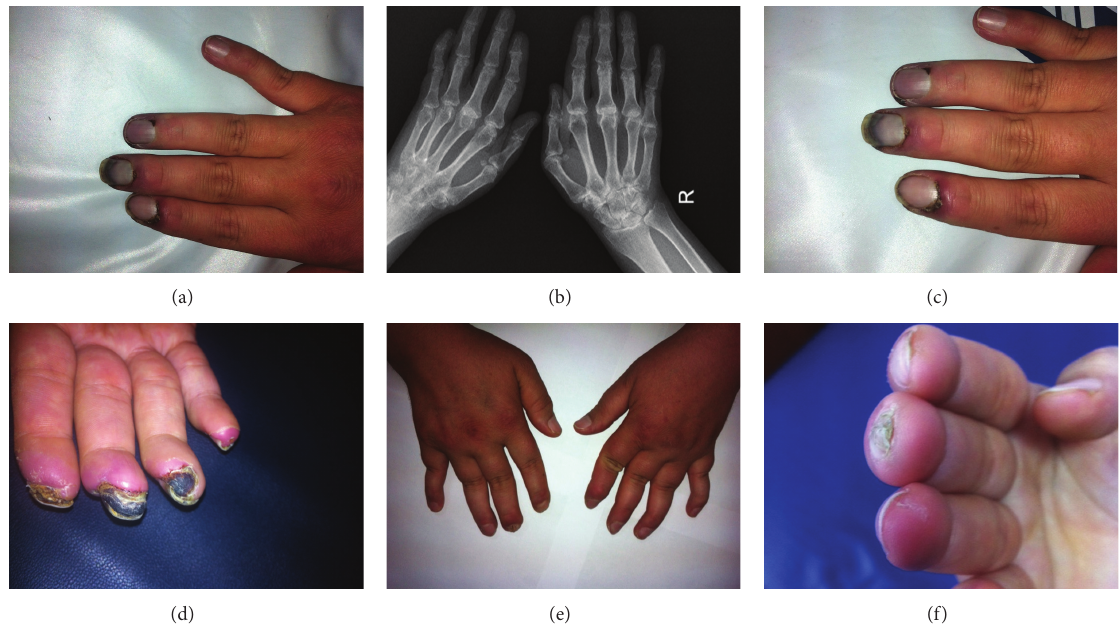
Figure 1: (a) Right hand with swan neck and Z deformity of the thumb (before treatment). (b) Radiograph; AP of bilateral hands suggesting Jaccoud radiological features. (c) Digital ulcers of the second to fourth digits of the right hand (2 weeks after initial treatment with cyclophosphamide). (d) Unresponsiveness to initial treatment demonstrated by a serious progression from ischemic lesions to digital gangrene lesions of the second to fourth digits of the right hand (one month after initial treatment regimen; cyclophosphamide, corticosteroids, and prostaglandins). (e) Response to treatment observed after first cycle of rituximab therapy (5 months following the start of RTX treatment). (f) Complete remission of digital gangrenous lesions after 2 cycles of rituximab therapy (10th month of the RTX treatment protocol (rituximab, glucocorticoid, aspirin, azathioprine, and